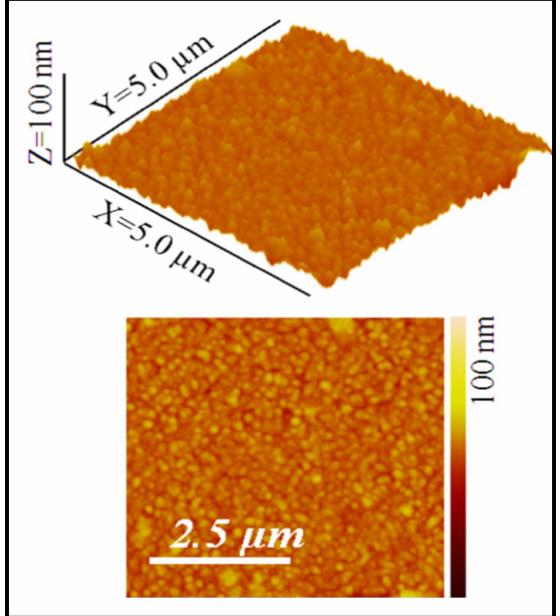
Figure 3. (Color online) Two-dimensional and three-dimensional AFM micrographs of LCO thin film deposited on STO with an annealing temperature of 900 ◦ C.